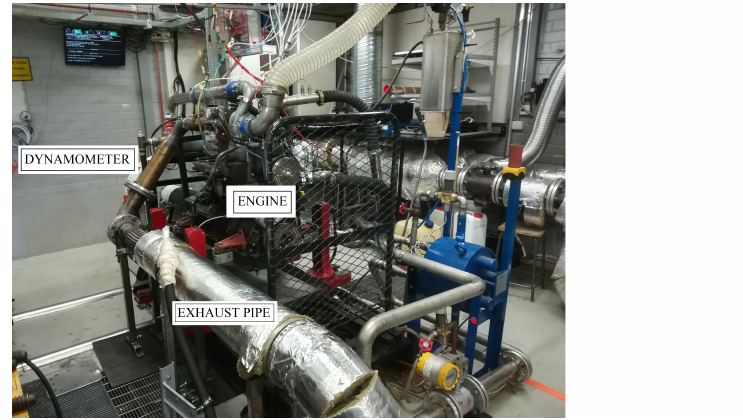
Figure 4. Experimental setup of AGCO Power 49 engine